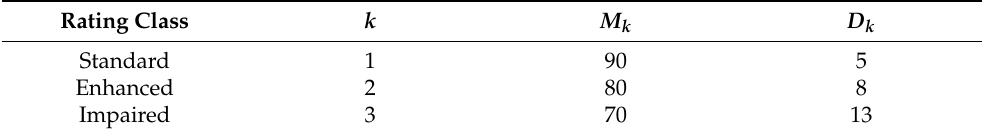
Table 1. Parameters of the Gompertz